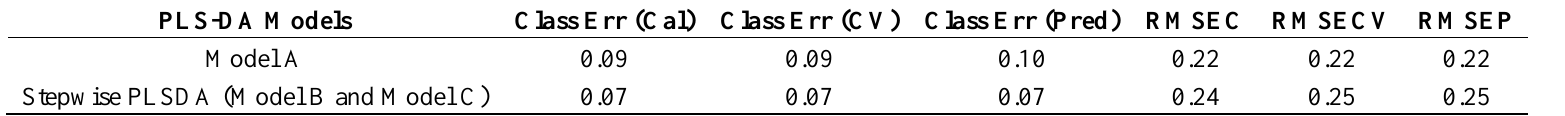
Table 5. Average classification error of PLSDA